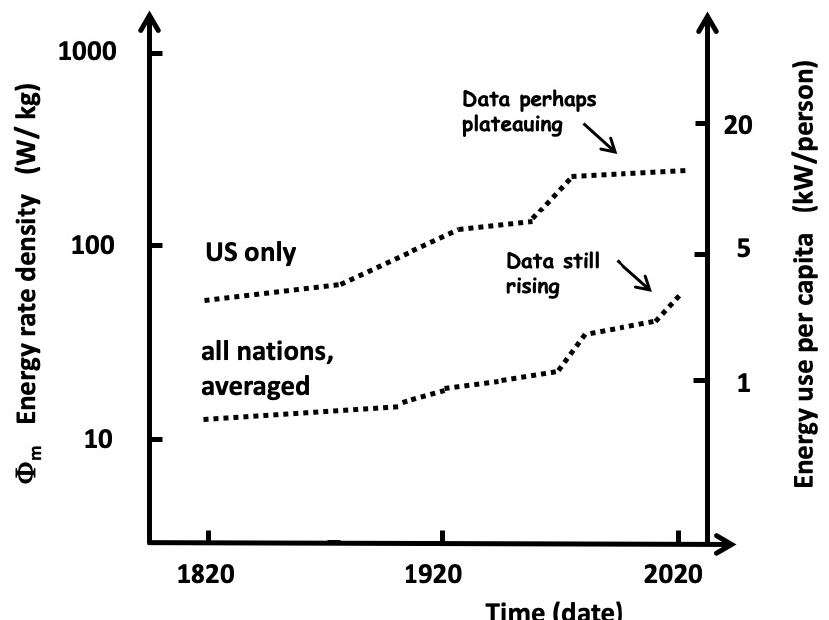
Figure 2. High energy usage for human society is a hallmark of our modern technological civilization. This semi-log graph plots Φ m values at left and equivalent per-capita energy usage at right over the past two centuries for the US only and for all nations of the world (including the US). These data suggest Φ m is flattening for the US, yet is still rising for all nations combined.